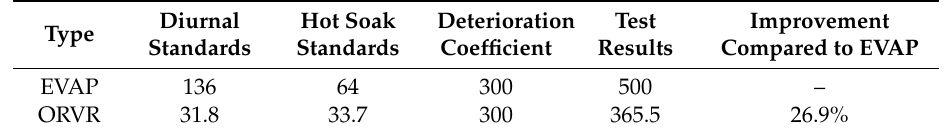
Table 3. Evaporative emission test results of EVAP and ORVR (Onboard Refueling Vapor Recovery) systems (1).